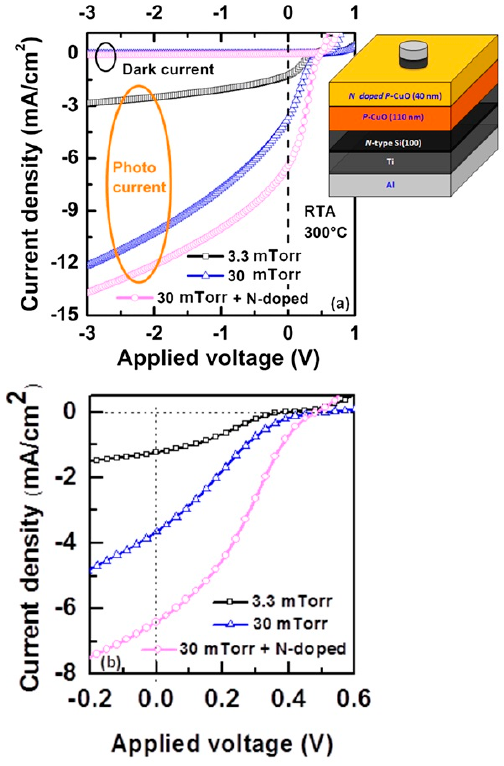
Figure 9. ( a ) Comparison of dark current and photocurrent densities of p-CuO/n-Si heterojunction solar cells with CuO deposited at 3.3 and 30 mTorr working pressures. The open circuit voltage and photocurrent increased significantly for the sample deposited under high working pressure. Inset of the figure shows schematic diagram of nitrogen-doped CuO device; ( b ) Variation of open circuit voltage and short circuit current of the solar cells © 2014 John Wiley & Sons, Ltd. [41].